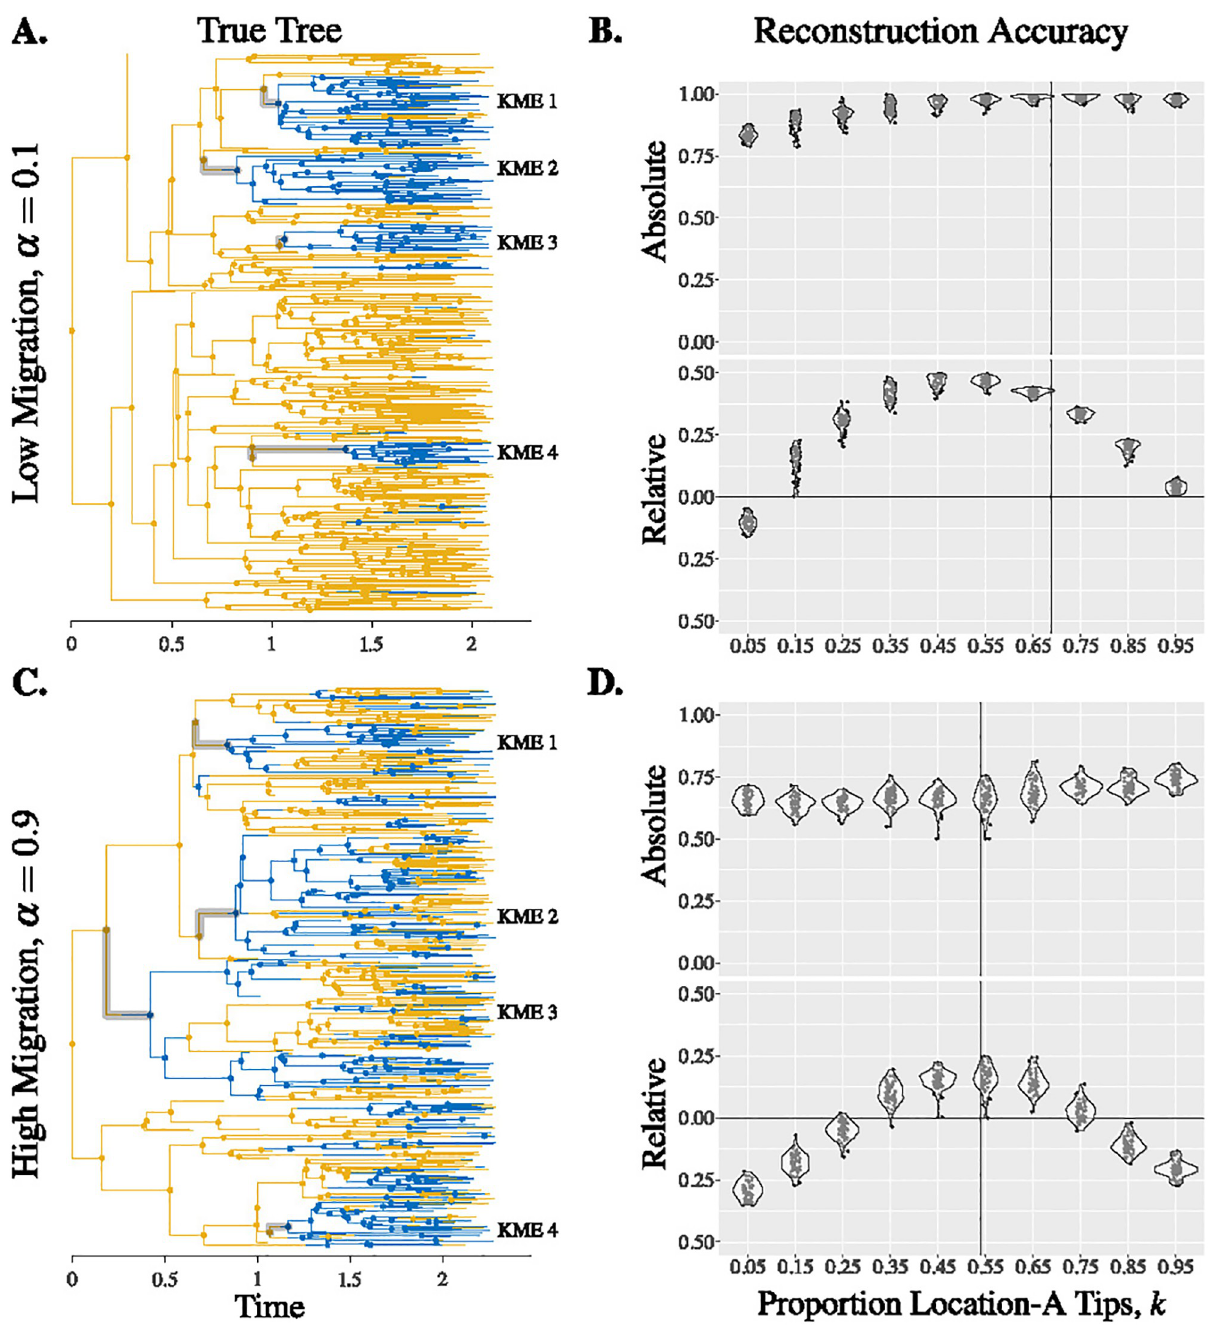
Fig 1. Reconstruction accuracy depends on sampling bias and migration rate. Panels A & C: True trees simulated with low or high migration rates, KMEs are highlighted. Panels B & D: Absolute and relative accuracy of downsampled trees. Each data point represents a downsampled tree from the true tree on the left. The vertical lines indicate the proportion of location-A tips in the true trees. Parameters: λ = 4 and μ = 1.